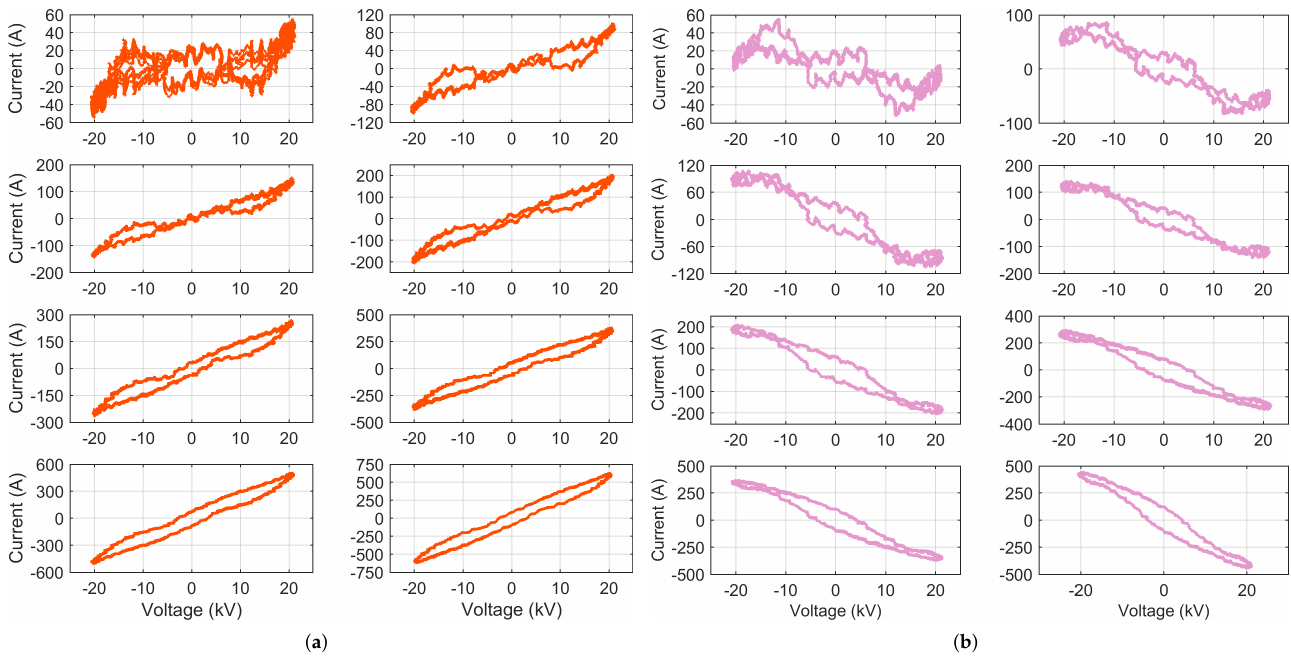
Figure 4. Typical VI trajectories for Switzerland (from low to high current intensities, top to bottom):